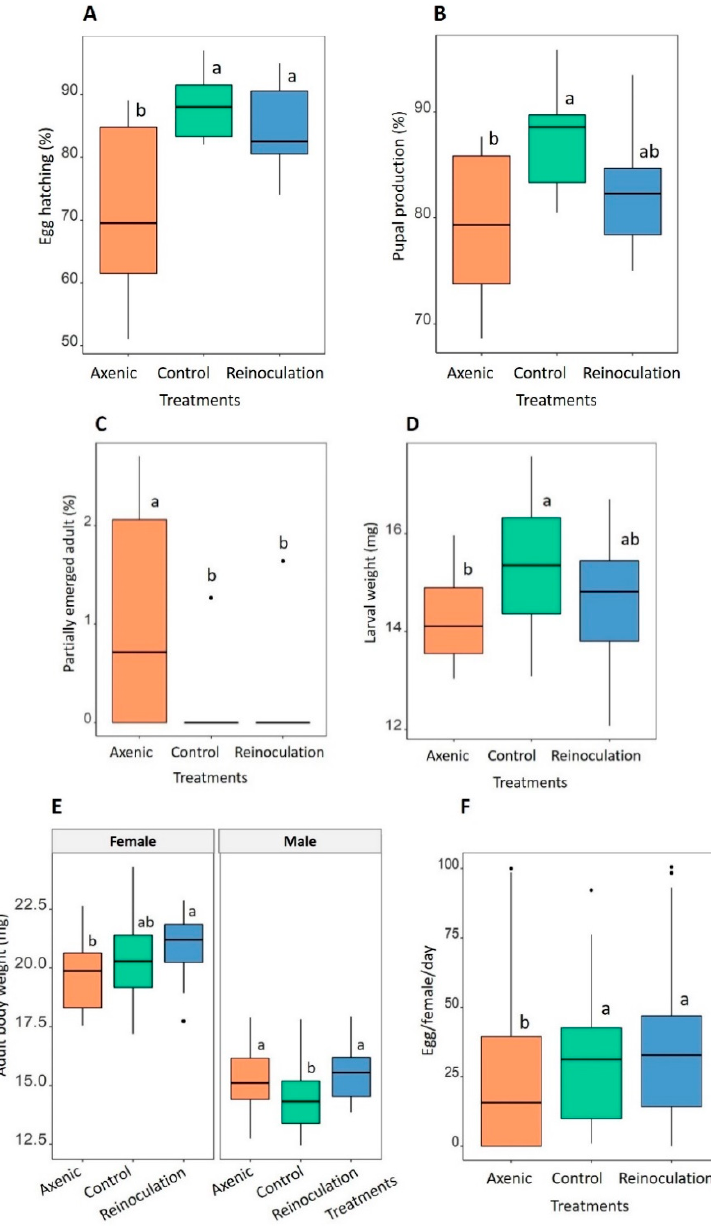
Figure 1. Effect of parental microbiota manipulation on ( A ) percentage of egg hatching, ( B ) pupal production, ( C ) partially emerged adults, ( D ) body weight of larva, ( E ) body weight of adult, and ( F ) female fecundity. Different letters indicate a significant difference between the treatments (( A , B , D – F ) SNK post hoc test and ( C ) Dunn post hoc test, p < 0.05)).